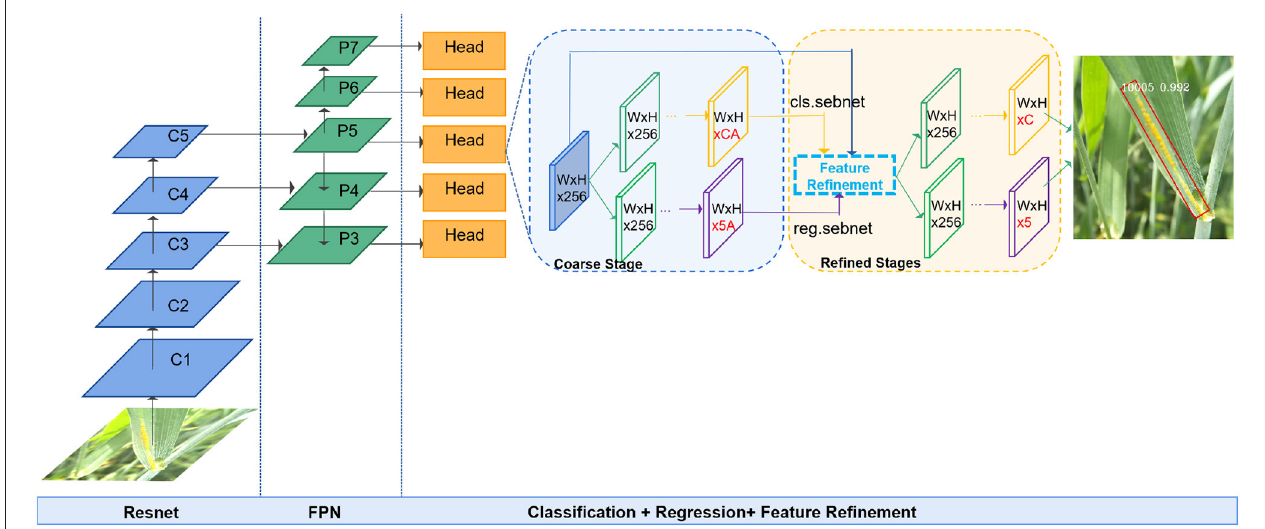
FIGURE 6 | Schematic representation of WSRD-Net framework. The model uses ResNet as a backbone and builds a feature pyramid network (FPN) on top of the ResNet architecture. Two task-specific subnetworks and FRM. “A” denotes the number of anchors on each feature point, “C” denotes the number of categories, and “5” indicates the coordinates and orientation of the bounding box.